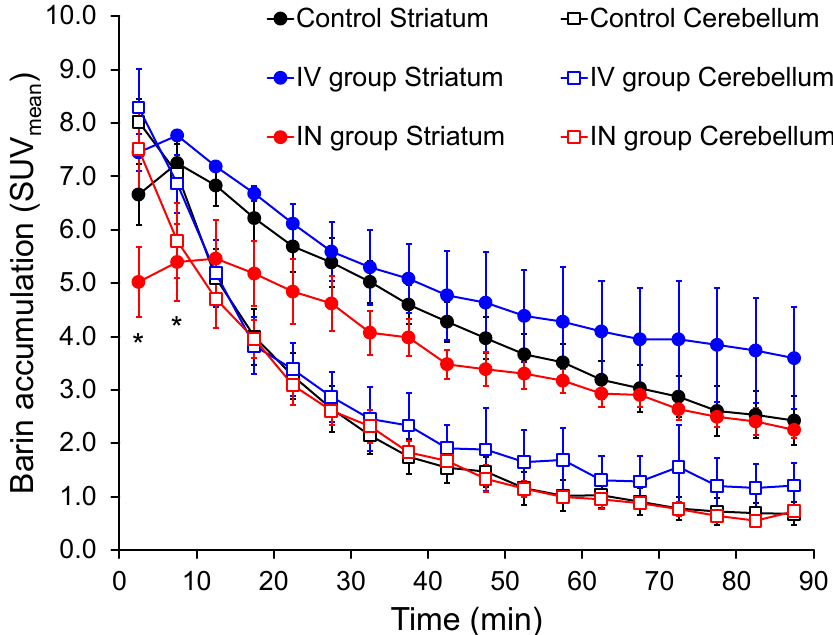
Figure 4. Time–activity curves for the striatum and cerebellum in [ 123 I]IBZM SPECT images of the control, IV, and IN groups. In the striatum, there is no significant difference between the control and IV groups with domperidone, but values are significantly lower in the IN group during the first 10 min compared with the control and IV groups. In the cerebellum, there is no significant difference among the groups. * p < 0.05 between control and IN group or IV and IN group.